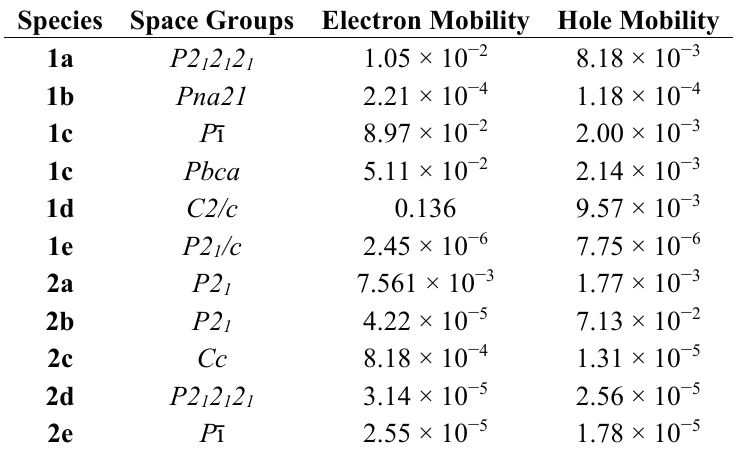
Table 5. The electron and hole mobility of the designed molecules. [T = 298 K, in cm 2